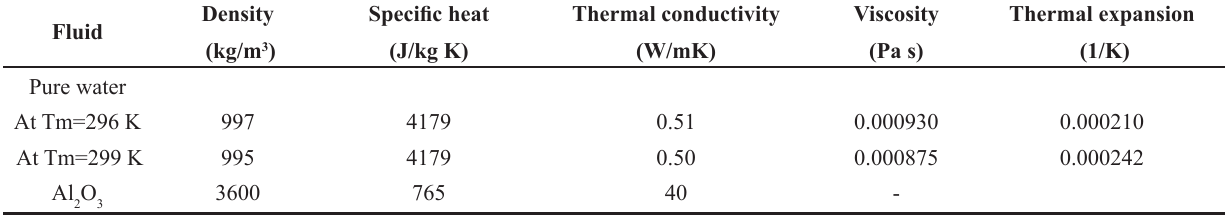
Table 2. Thermophysical properties of